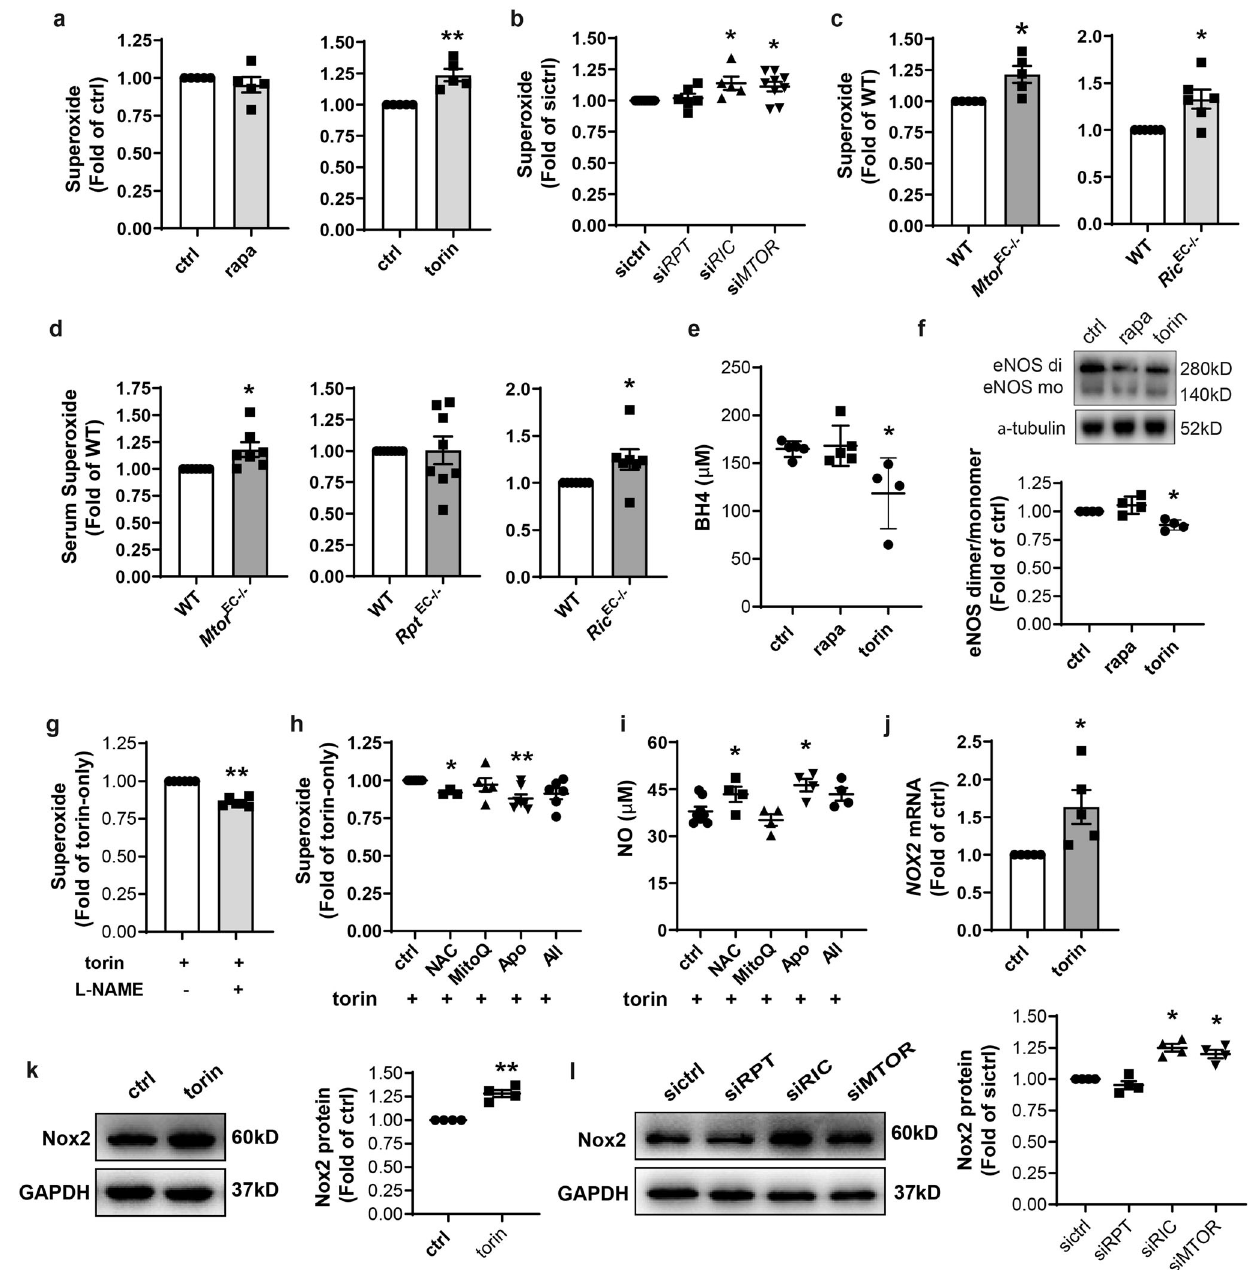
Fig. 5 Inhibition of mTORC2 promoted ROS accumulation and eNOS uncoupling. a HAEC were treated with 1 nM rapa or 10 nM torin for 1 h followed by incubation with dihydroethidium (DHE) for detection of intracellular superoxide with fl ow cytometry ( n = 5). b HAEC were transfected with siRNA prior to fl ow cytometric measurement of intracellular superoxide ( n = 5 – 9). c Primary endothelial cells (EC) were isolated from Mtor EC − / − or Rictor EC − / − mice and their WT littermates to measure intracellular superoxide ( n = 5 – 6). d Serum superoxide levels were measured in Mtor EC − / − , Rpt EC − / − and Ric EC − / − mice with chemiluminescent assay ( n = 7 – 9). e HAEC were treated with 1 nM rapa or 10 nM torin for 1 h followed by ELISA measurement of BH4 ( n = 4 – 5). f After treatment, eNOS dimer (di) to monomer (mo) ratio was evaluated by native PAGE followed by western blotting ( n = 4). g After pretreatment with L-NAME (500 nM) for 0.5 h ( n = 3 – 6), HAEC were incubated with 10 nM torin for 1 h prior to measurement of intracellular superoxide with fl ow cytometry. h , i After 1 h pretreatment with N-acetylcysteine (Nac, 2 mM), MitoQ (1 µ M), Apocynin (Apo, 20 µ M), or Allopurinol (All, 50 µ M) ( n = 3 – 4), HAEC were incubated with 10 nM torin for 1 h prior to measurement of superoxide inside HAEC ( f ) and NO in the medium ( g ). j HAEC were treated with 10 nM torin for 1 h prior to quantitative PCR ( n = 5). k , l HAEC were treated with 10 nM torin or transfected with siRNA followed by Western blotting to quantify Nox2 expression ( n = 4). Error bars correspond to standard error of the mean (SEM). * p < 0.05; ** p < 0.01 vs. ctrl, WT, sictrl or torin-treated ctrl; one-sample t test ( a , c , d , g , j , k) or RM one-way ANOVA with Dunnett ’ s test ( b , f , h , l ) or one-way ANOVA with Dunnett ’ s test ( e , i ).